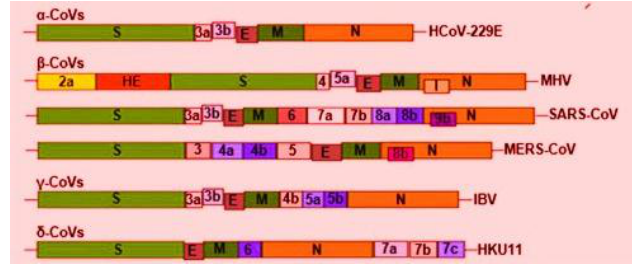
Figure 1 : The four genera of Coronaviruses genomic